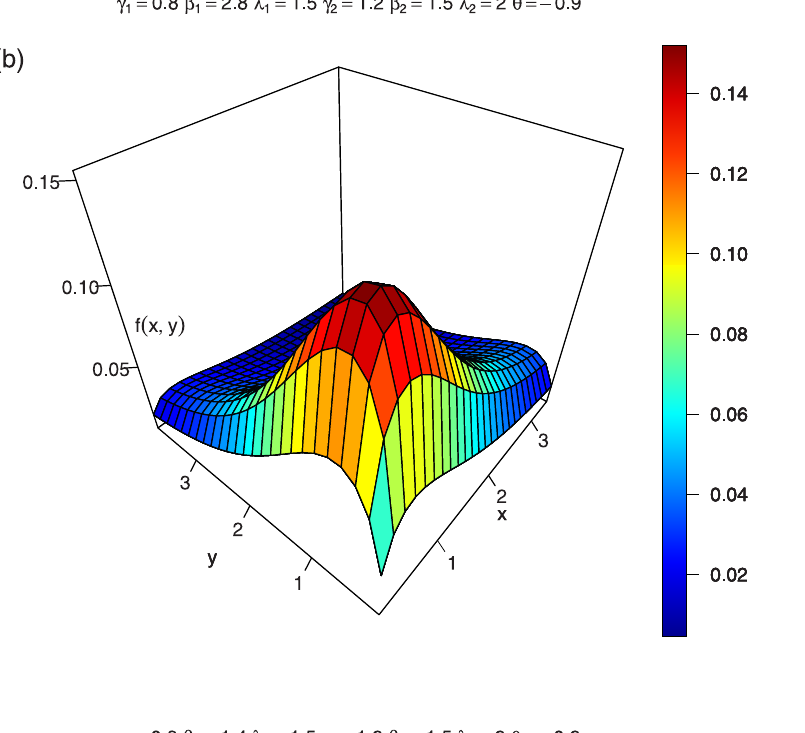
Fig 3. 3-dimension of joint density of